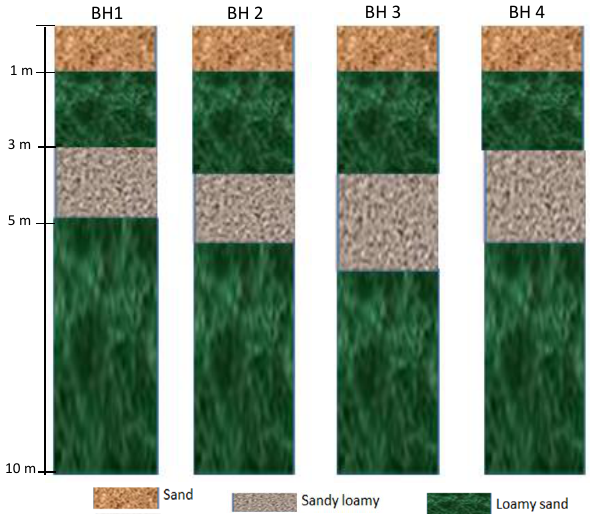
Figure 5. Combined soil profile at BH1, BH2, BH3 and BH4 bores.